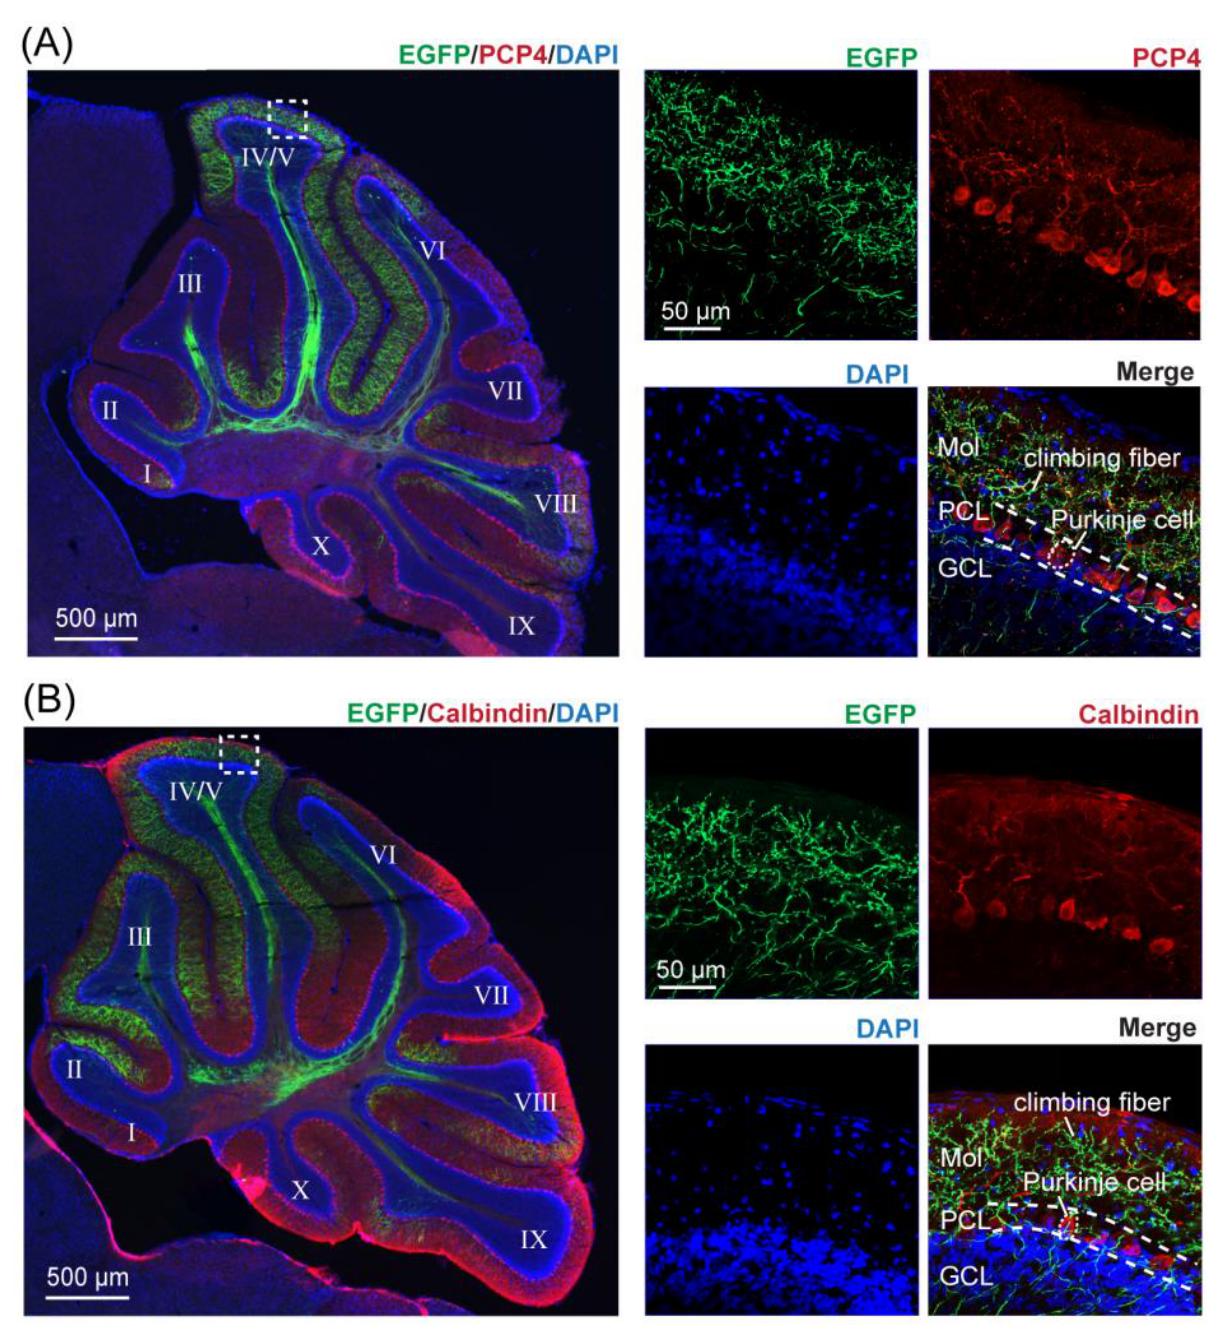
Figure 3. Resulting CF distribution in the cerebellar cortex following injections into the inferior olive (IO). All parasagittal brain sections are from one mouse following an injection of anterograde tracer into the caudal IO. ( A ) Confocal images of the cerebellum immunostained with anti-PCP4 ( A ) or anti-Calbindin-D28K ( B ) shown in red and CF labeling in the molecular layer shown in green following injection of AAV2/8-hSyn-EGFP-WPRE-pA into the IO. Left, scale bar = 500 µ m. Right, enlargement of the dotted box in the left image, scale bar = 50 µ m. MoL, molecular layer; PCL, Purkinje cell layer; GCL, granule cell layer.